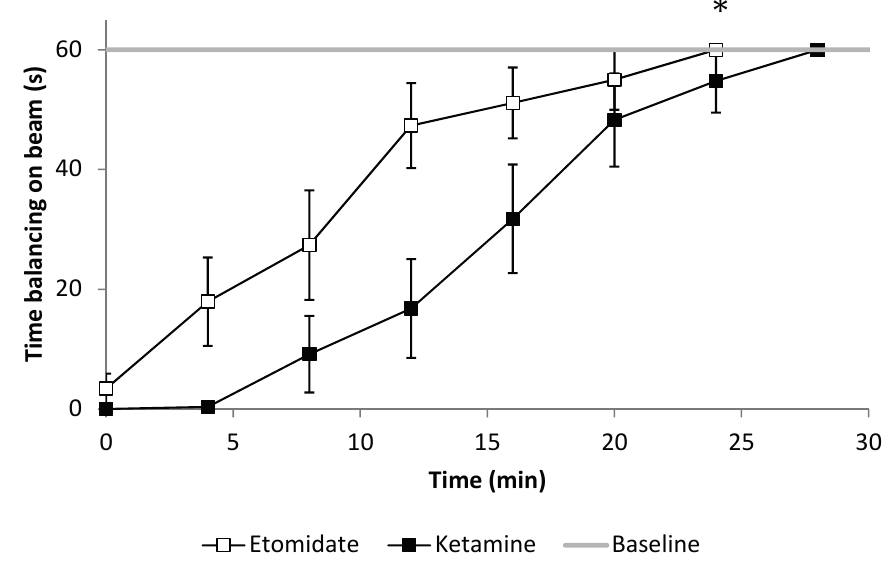
Figure 3. Functional mobility described as the ability to maintain balance on the beam, assessed every four minutes after emergence. After 2 and 4 mg/kg etomidate anesthesia, rats were able to hold themselves significantly longer on the beam compared to 20 and 40 mg/kg ketamine (* p = 0.021 for the slope of the gripping time comparison over time, n = 6). Error bars represent the